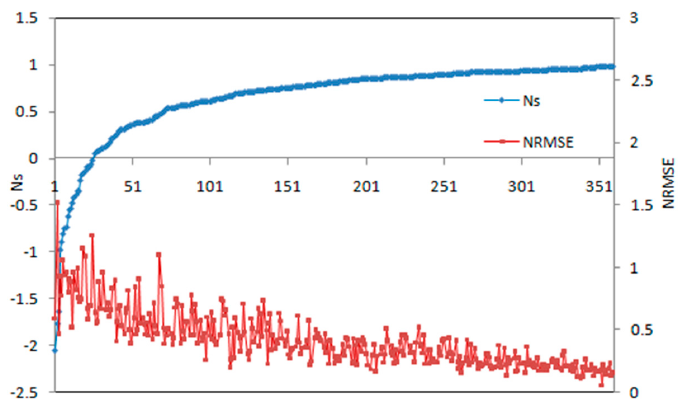
Figure 6. Comparison between Ns and NRMSE.